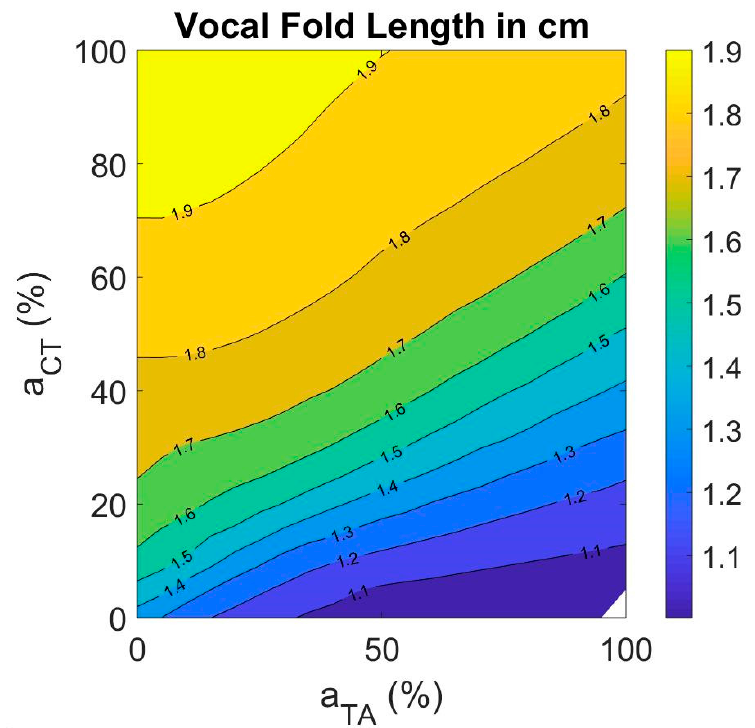
Figure 10. Muscle activation plot with vocal fold length as the contour feature.